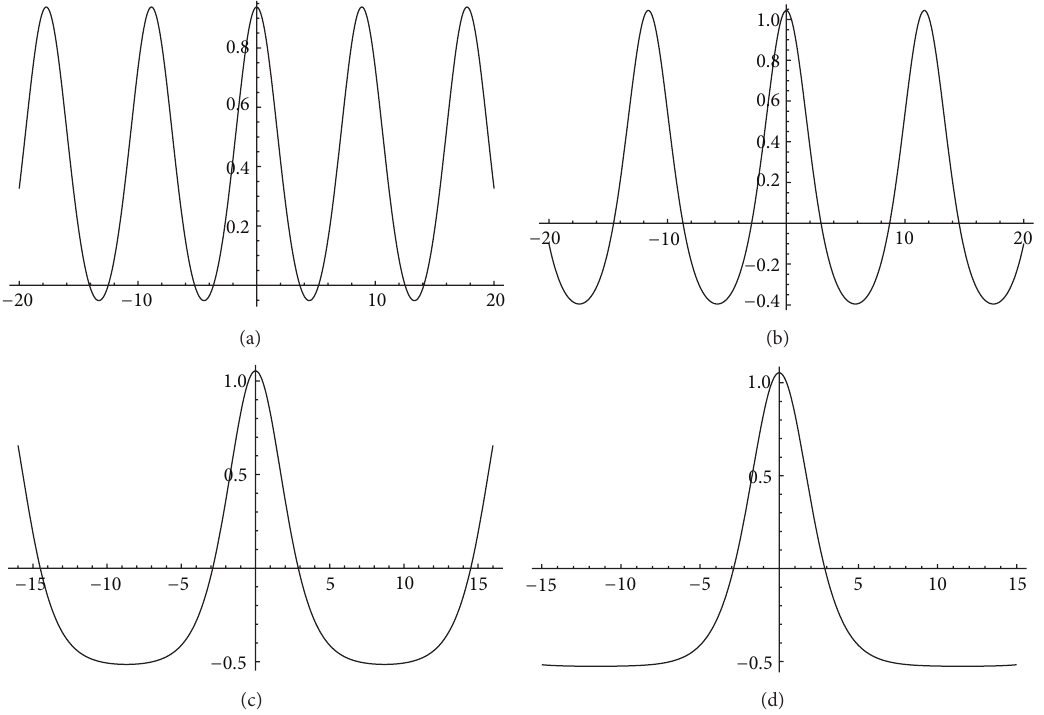
Figure 3: The varying process for graphs of 𝑢 9 (𝜉) when 𝑔 → 𝑔 2 − 0 , where 𝑎 = 1 , 𝑐 = 𝑏 = 𝑘 = 1/2 , and (a) 𝑔 = 𝑔 2 − 10 −1 ; (b) 𝑔 = 𝑔 2 − 10 −2 ; (c) 𝑔 = 𝑔 2 − 10 −4 ; (d) 𝑔 = 𝑔 2 − 10 −6